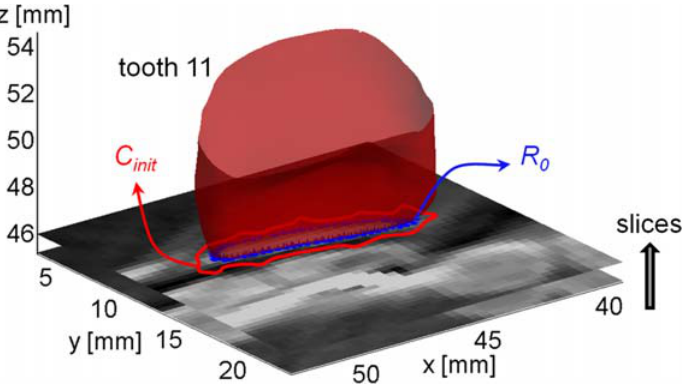
Figure 9. Initialization of the LSF for tooth 11 by using the optically scanned